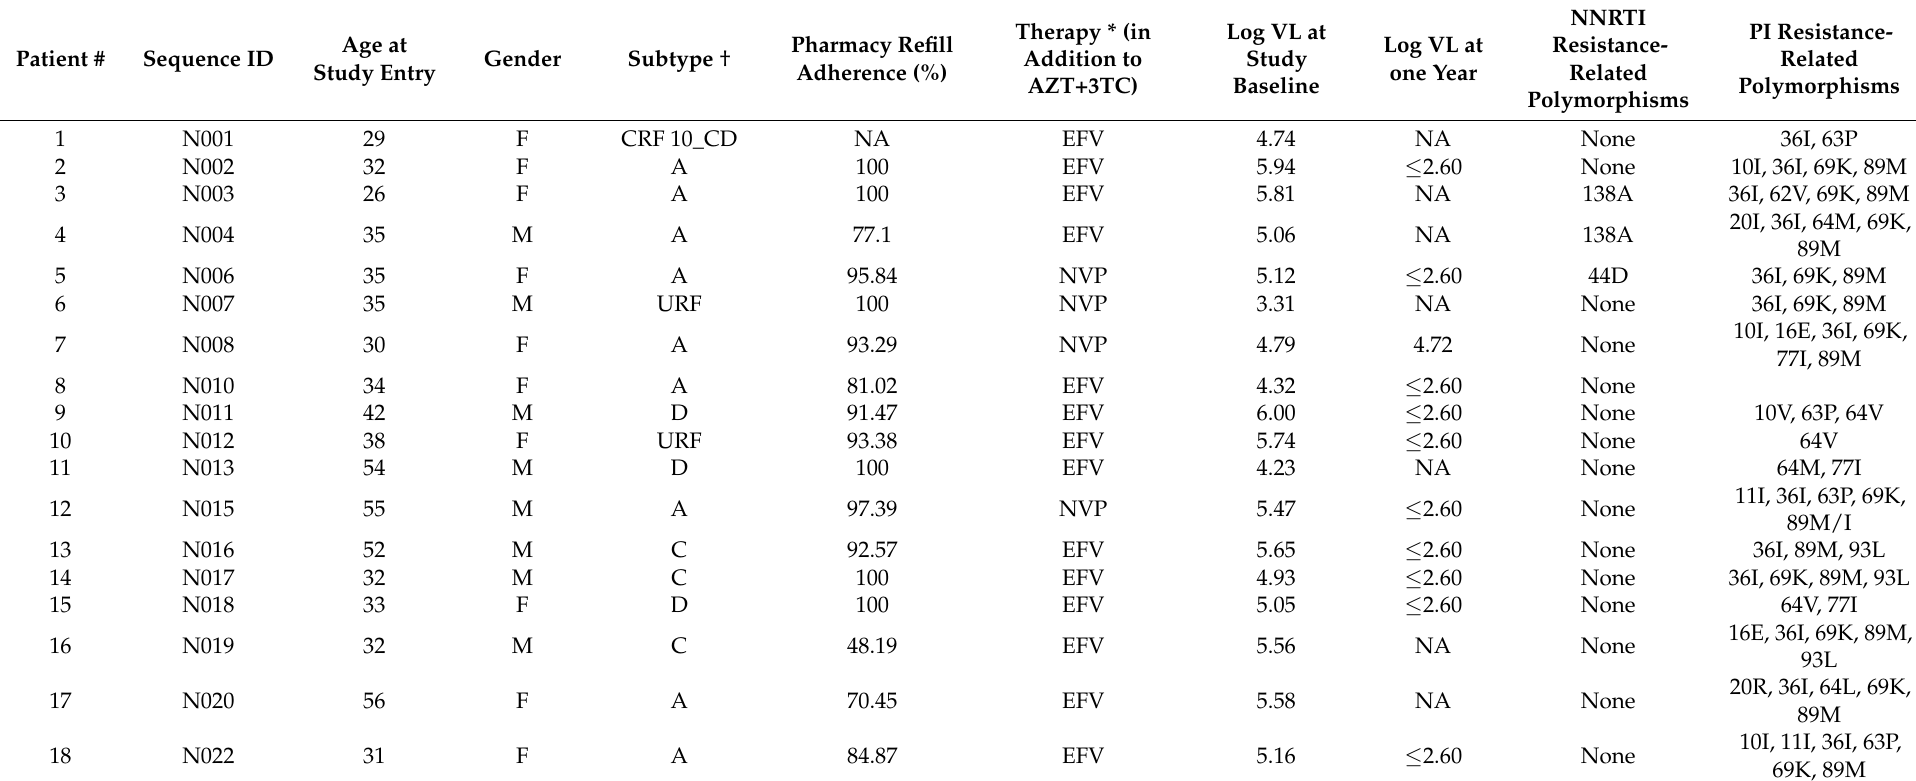
Table 1. Characteristics of patients and the mutations found in the RT and PR region from HIV isolates of the cART-naïve